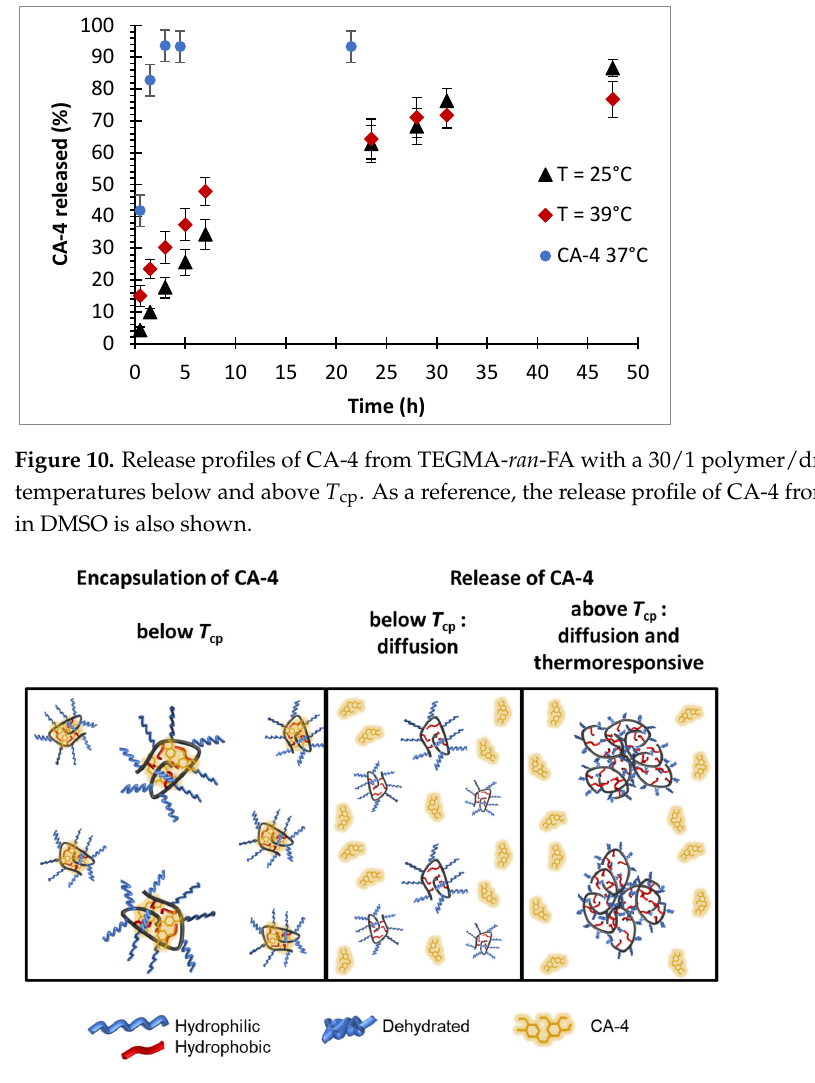
Figure 11. Schematic representation of the mechanism of release of the encapsulated CA-4 drug from TEGMA- ran -FA unimer micelles, below and above T cp .